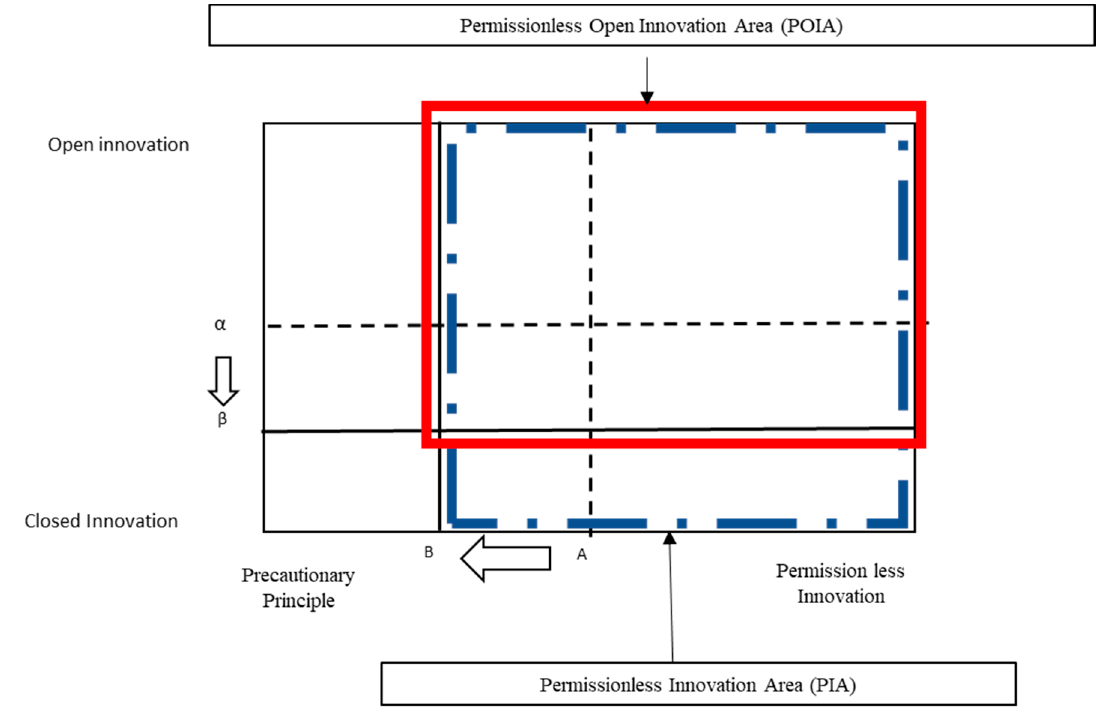
Figure 5. Reduction of Permissionless Innovation Area by adding Open Innovation.